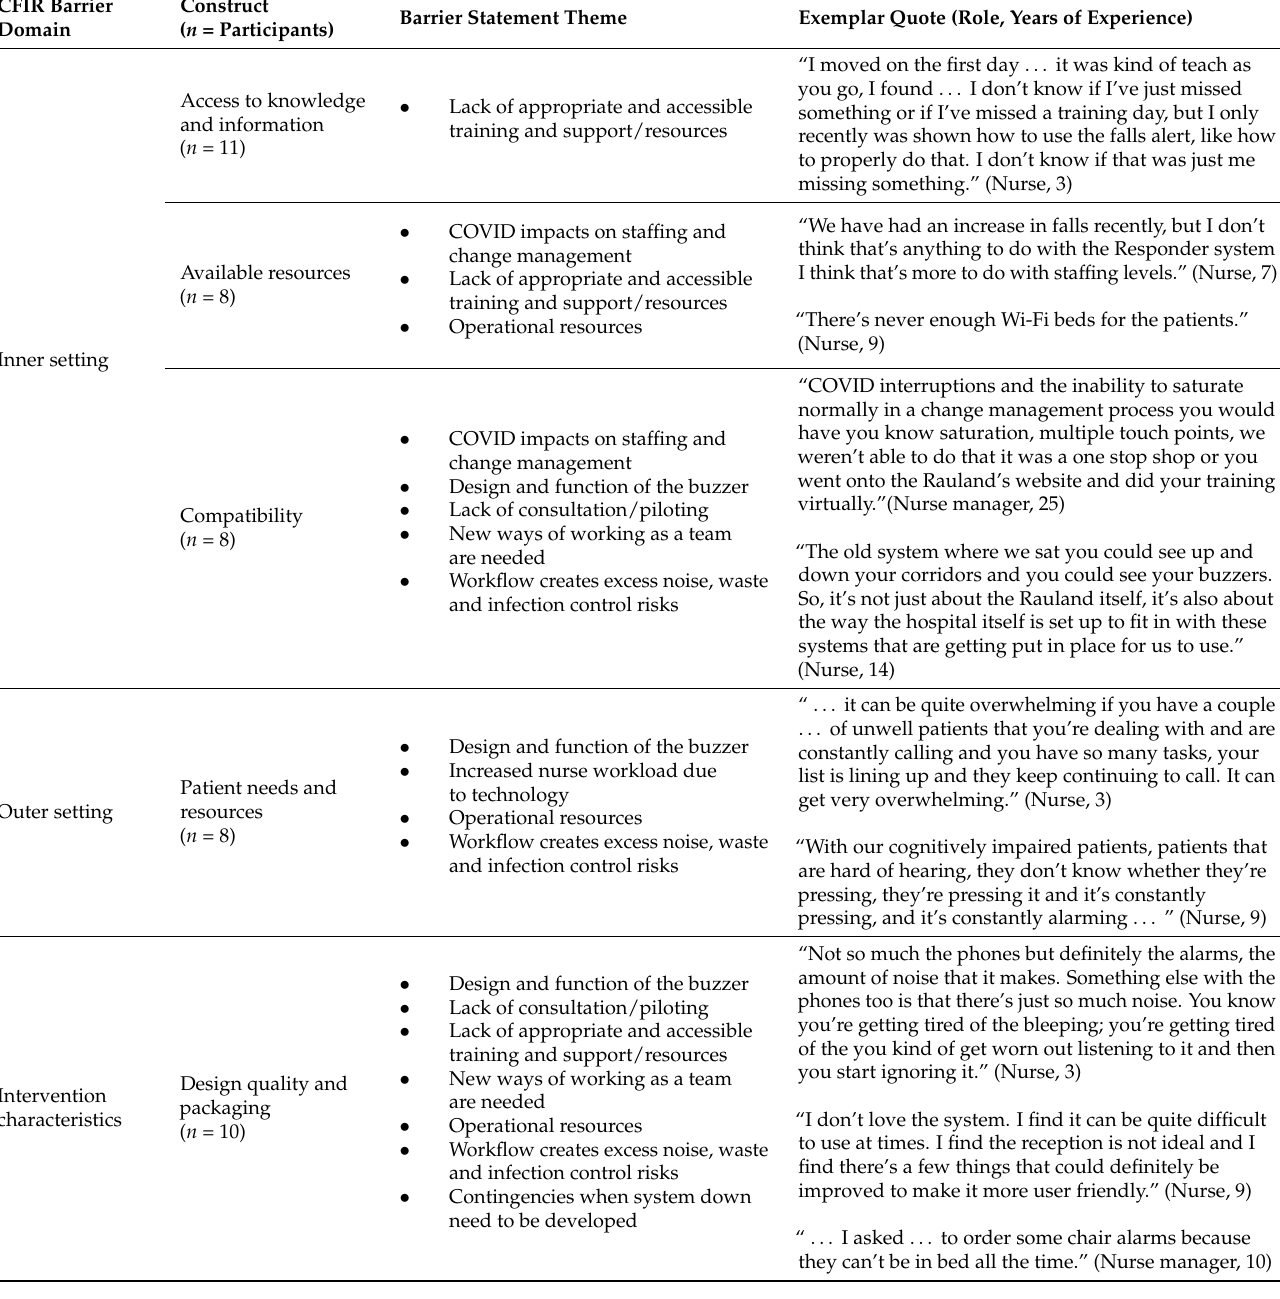
Table 3. Barrier coding